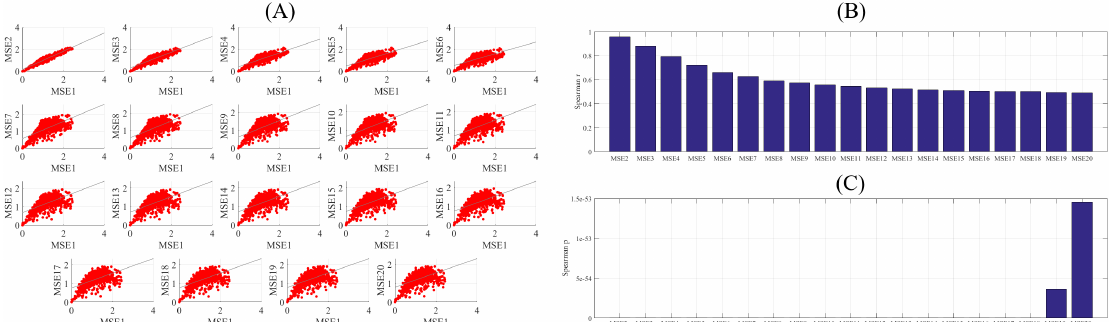
Figure A25. Positive affect’s Spearman correlations between MSE1 versus MSE2–MSE20. ( A ) Scatter plots of MSE1 versus MSE2–MSE20 ( B ) Spearman correlations associated with MSE2–MSE20 and MSE1 ( C ) Spearman correlations’ p -values associated with MSE2–MSE20 and MSE1. Table A17. Spearman correlations between MSE1 versus MSE2–MSE20 in negative affect. MSE1 vs.